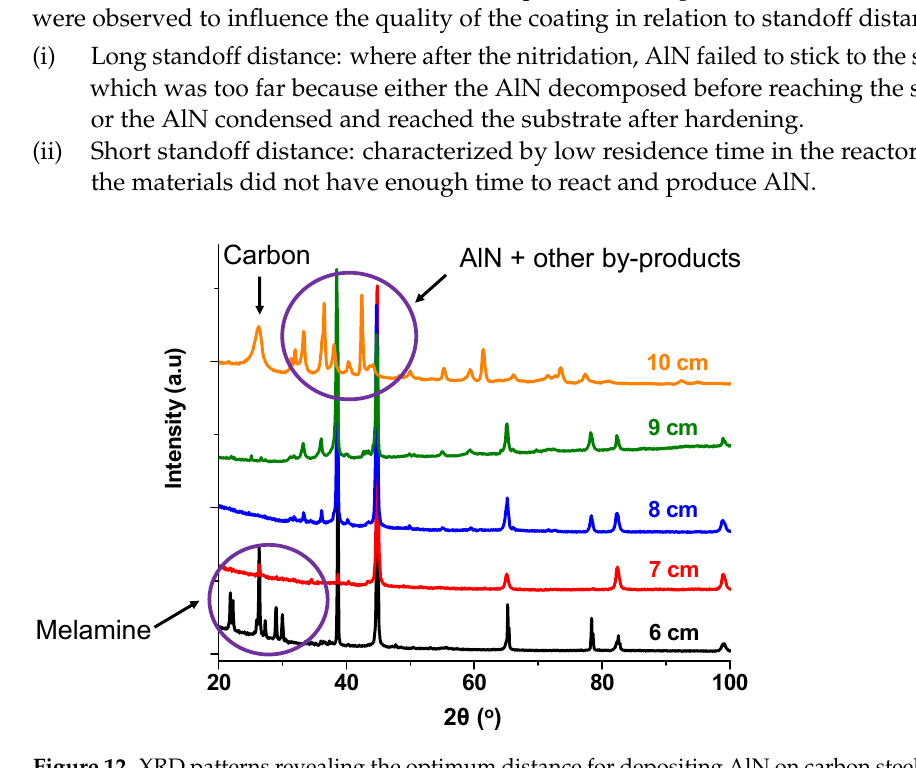
Figure 12. XRD patterns revealing the optimum distance for depositing AlN on carbon steel substrate using melamine and Al powder in hexadecane.